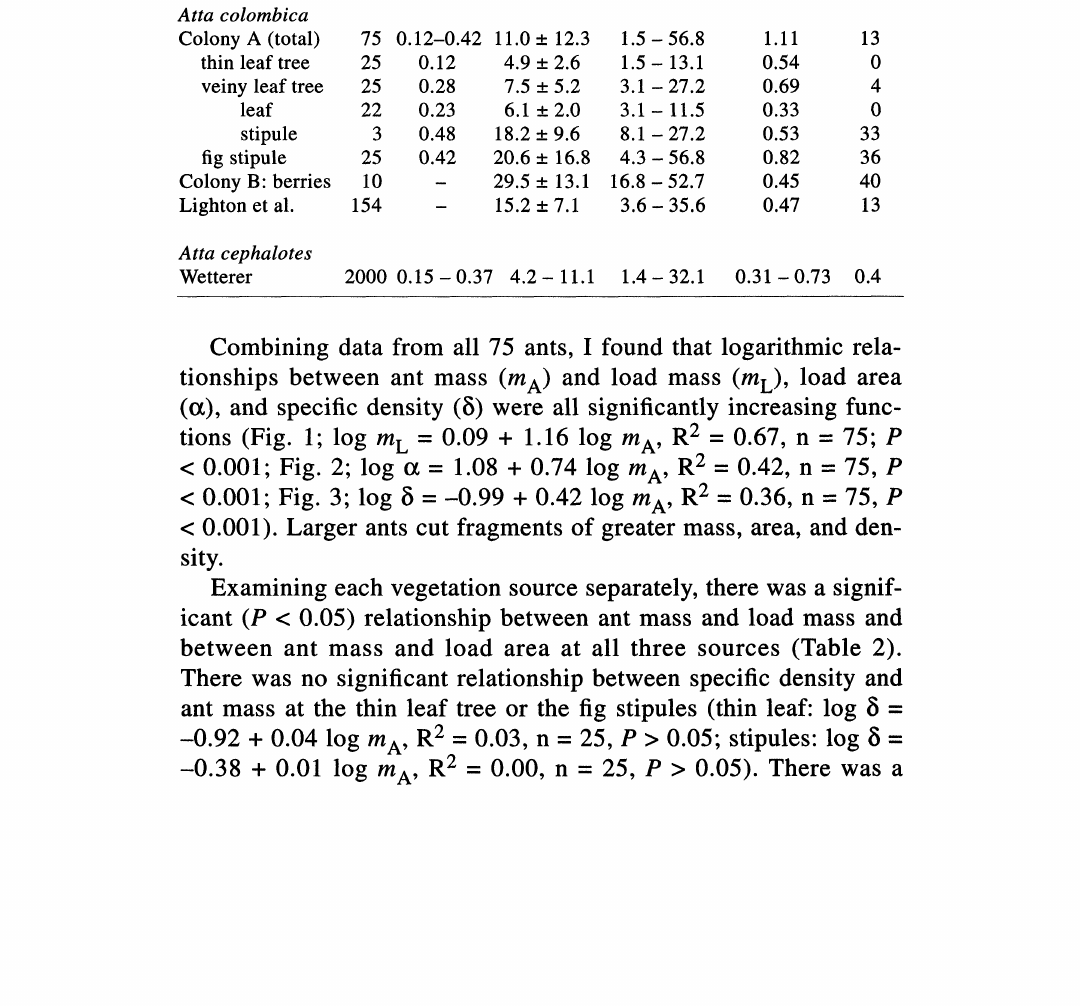
fig stipule Colony B: berries Lighton et